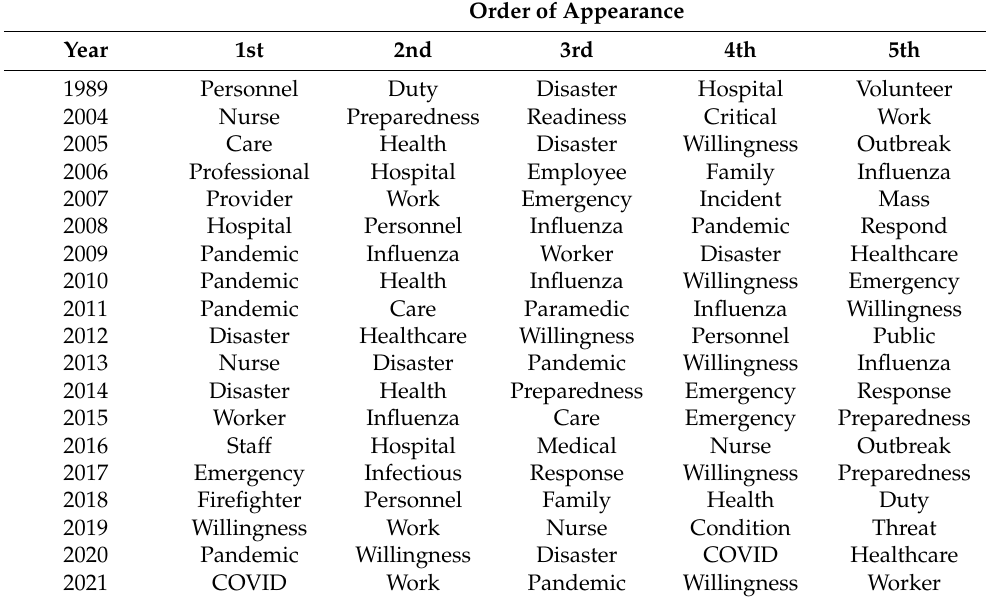
Table 8. Thematic evolution per year: 5 most frequent themes per year of